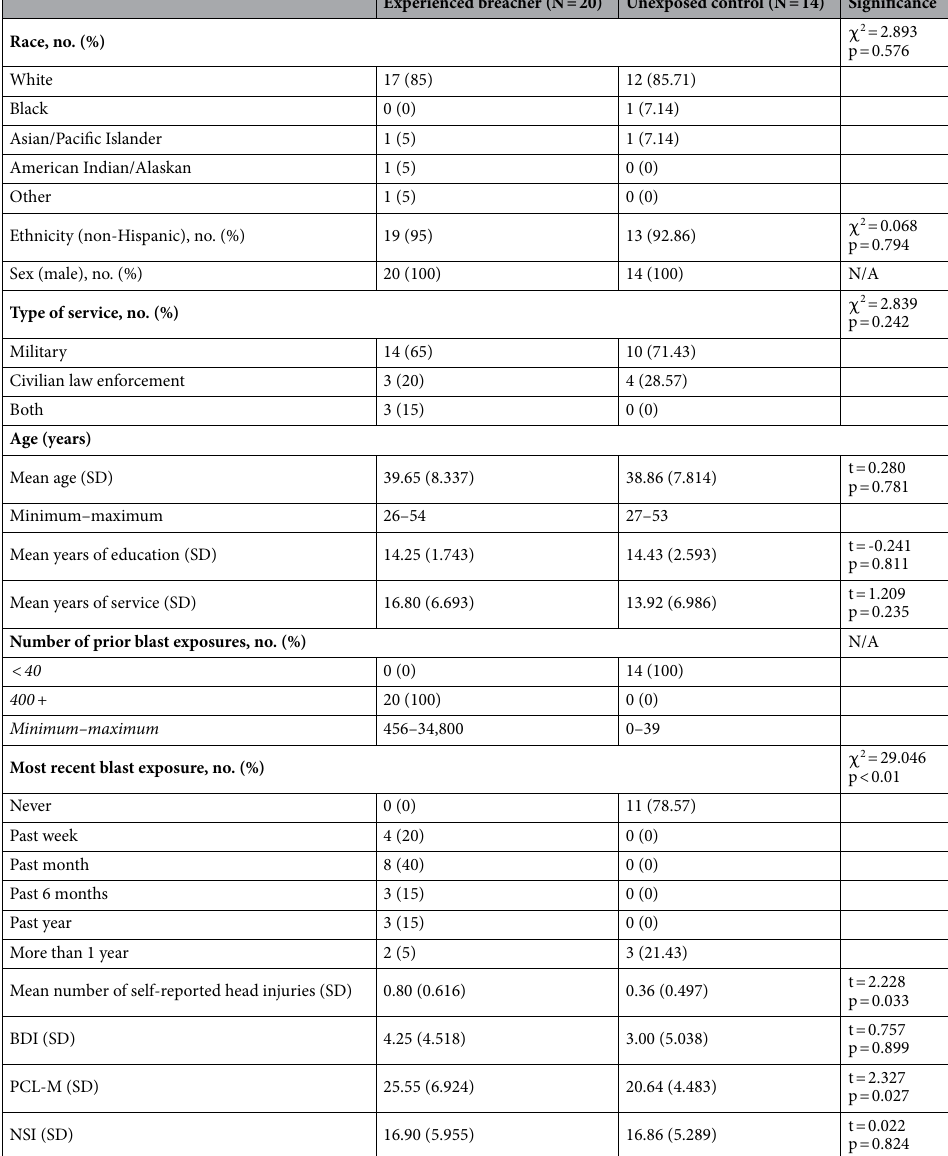
Table 1. Demographics and clinical characteristics. Data is described using mean and SD. BDI Beck Depression Index, PCL-M Post-Traumatic Stress Disorder Checklist-Military, NSI Neurobehavioral Symptom